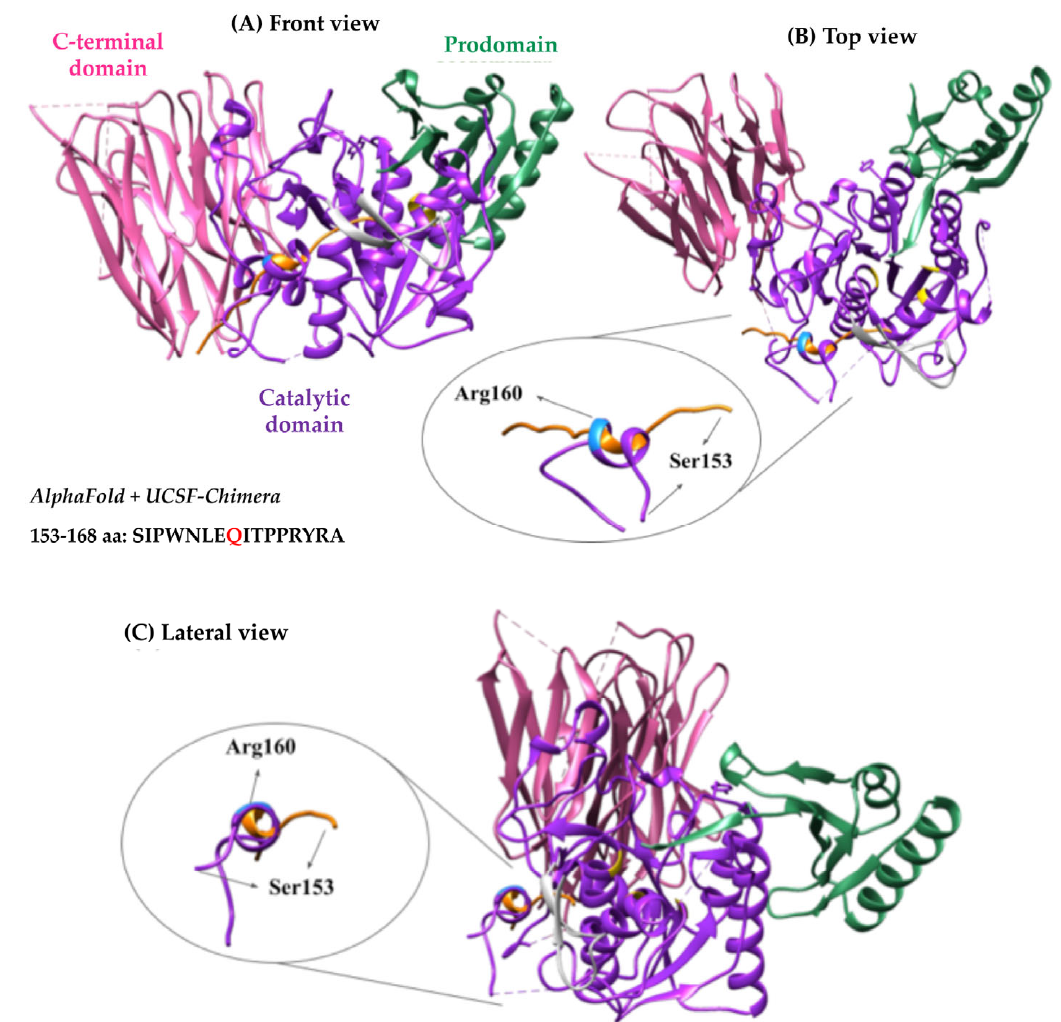
Figure 5. AlphaFold-2 structure prediction of the p.(Arg160Gln) PCSK9 variant compared to WT. Structures of the area of interest (amino acids 153–160) in both WT and p.(Arg160Gln) were compared to understand the nature of the variant. ( A ) Front view, ( B ) top view and ( C ) side view. In green, prodomain (31–152); in purple, catalytic domain (154–451); in pink, C-terminal domain (453–692). Inside the catalytic domain, Arg160 residue is coloured in blue, the catalytic triad in yellow (186, 226 and 386) and the LDLr binding site in grey (367–381).